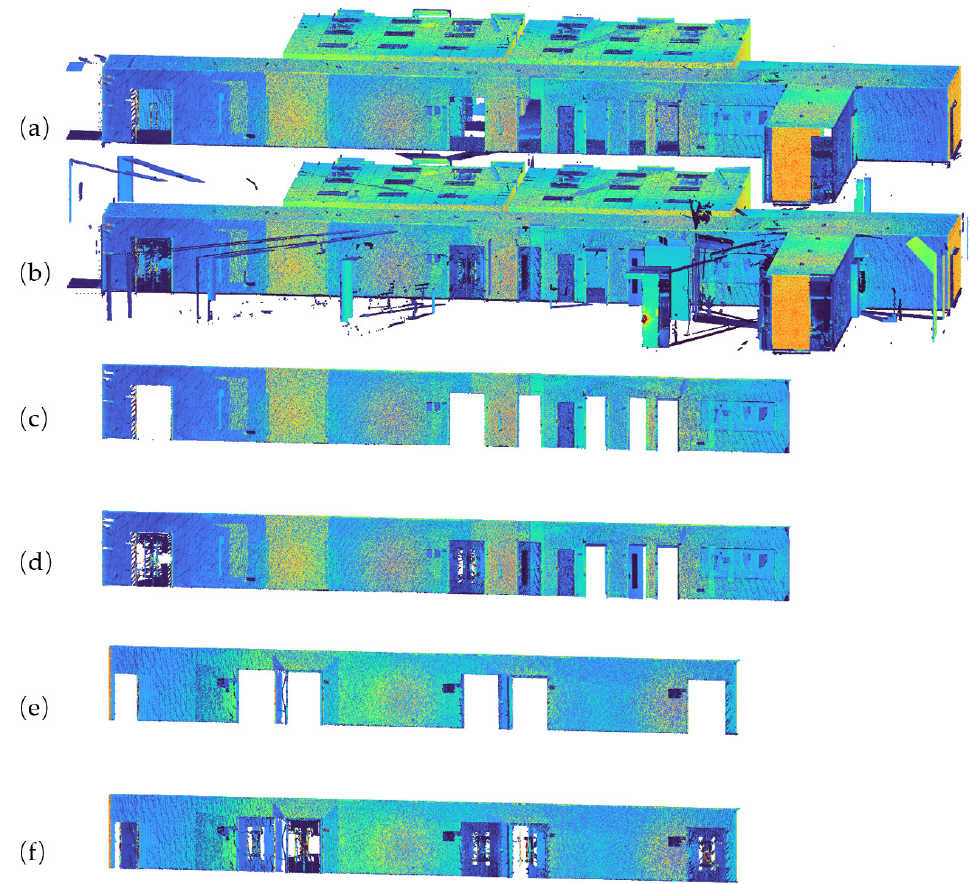
Figure 8. The detection and removal of the door information: the point cloud data with the doors removed ( a , c , e ) and the original point cloud data ( b , d , f ).